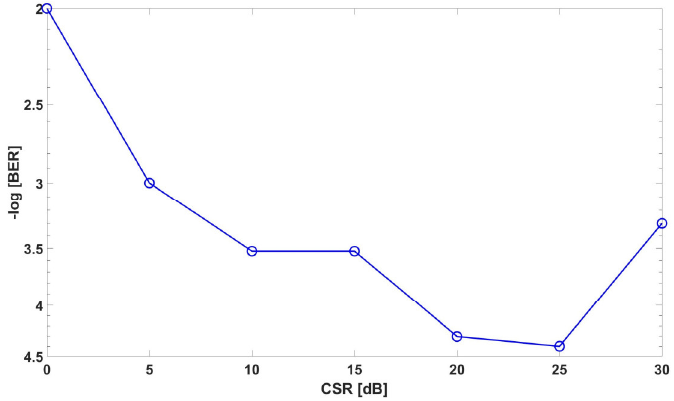
Figure 6. Bit error ratio (BER) for 10 km SMF with 3 m wireless distance for CSRs.